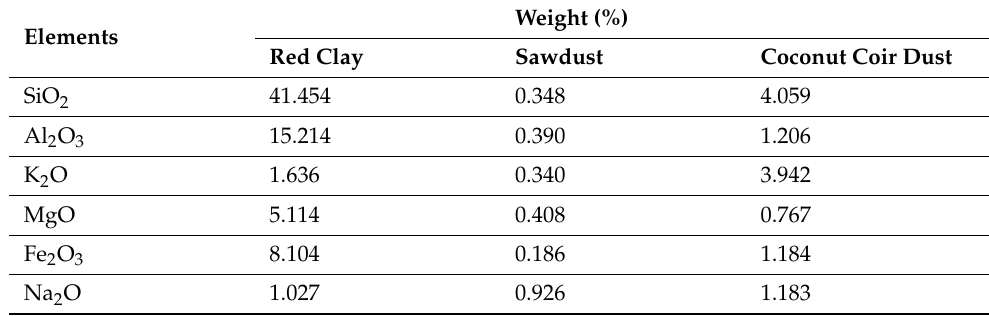
Figure 2. Thermal conductivity measurement of raw materials. Table 2. XRF analysis of the raw